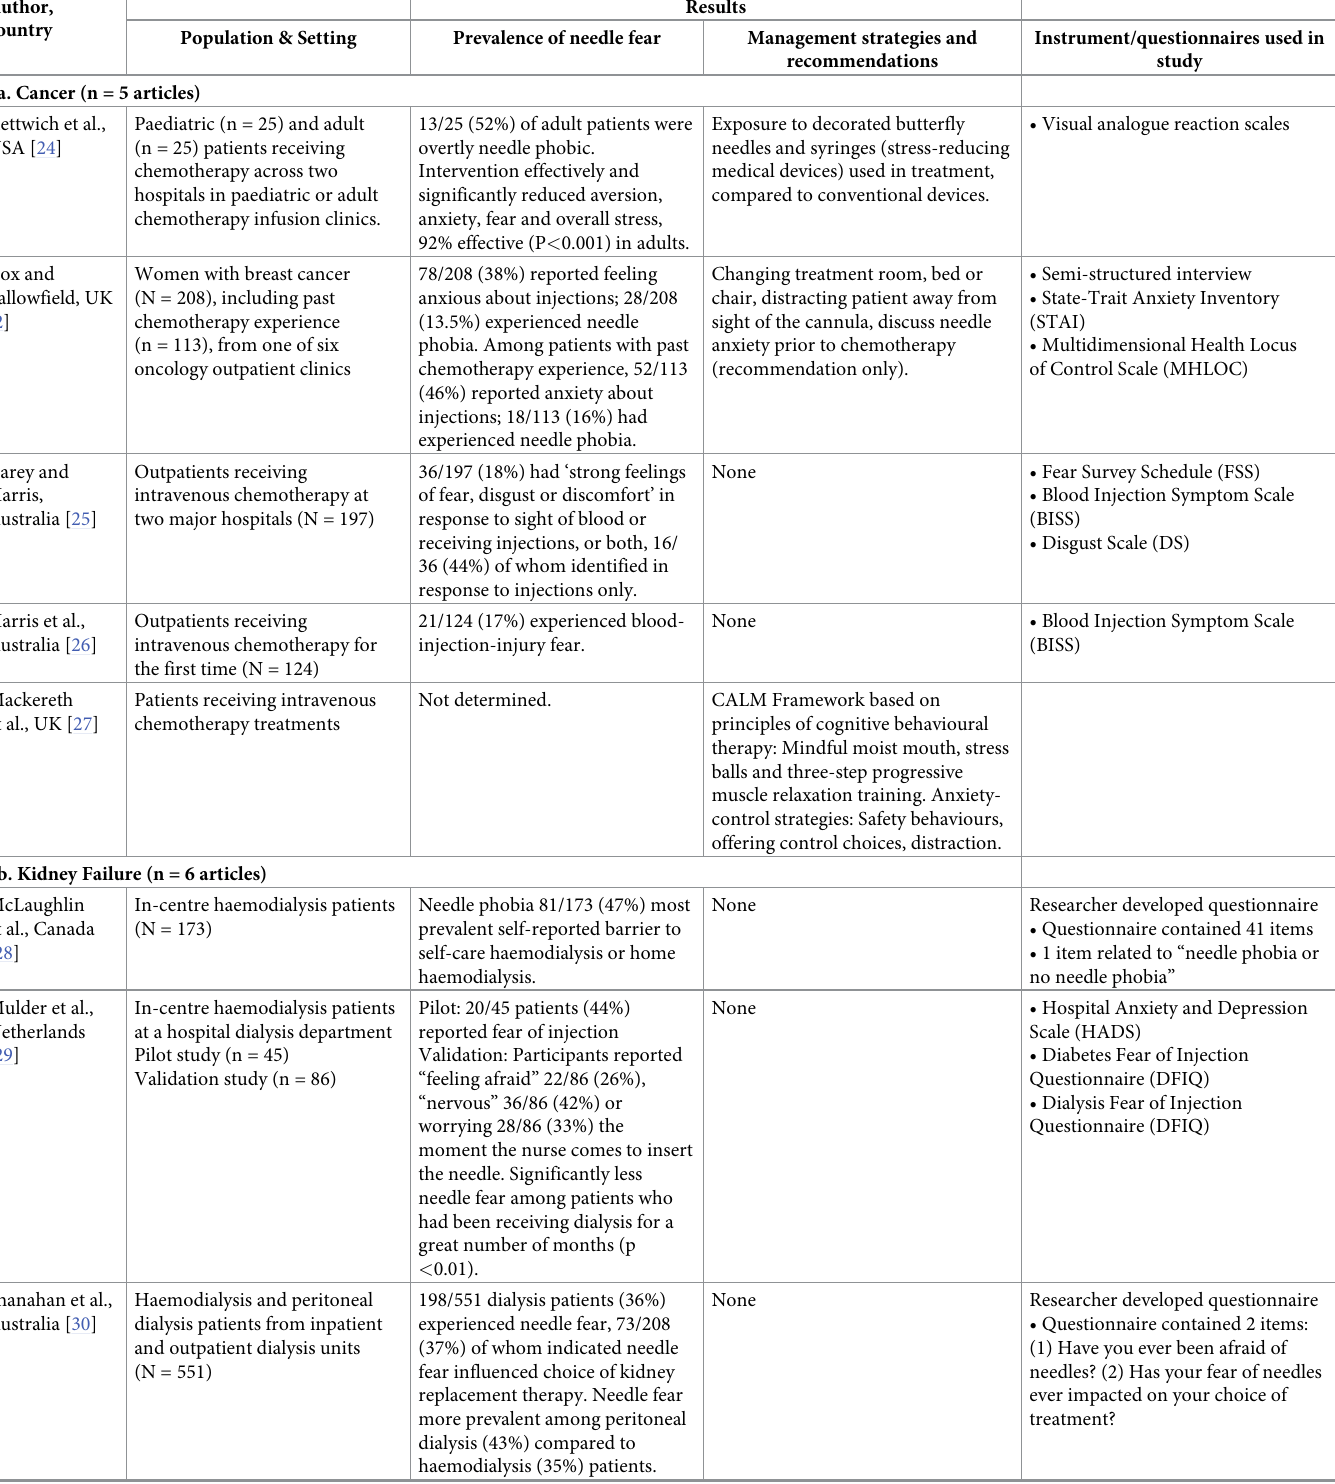
Table 2. Findings from included articles reporting needle fear prevalence and/or management strategies and recommendations in adult chronic disease